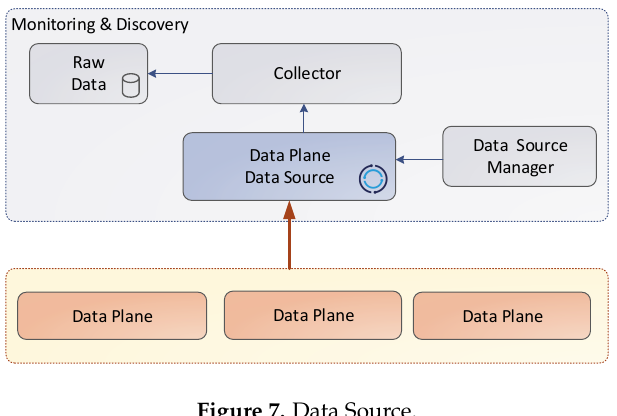
Figure 7. Data Source.